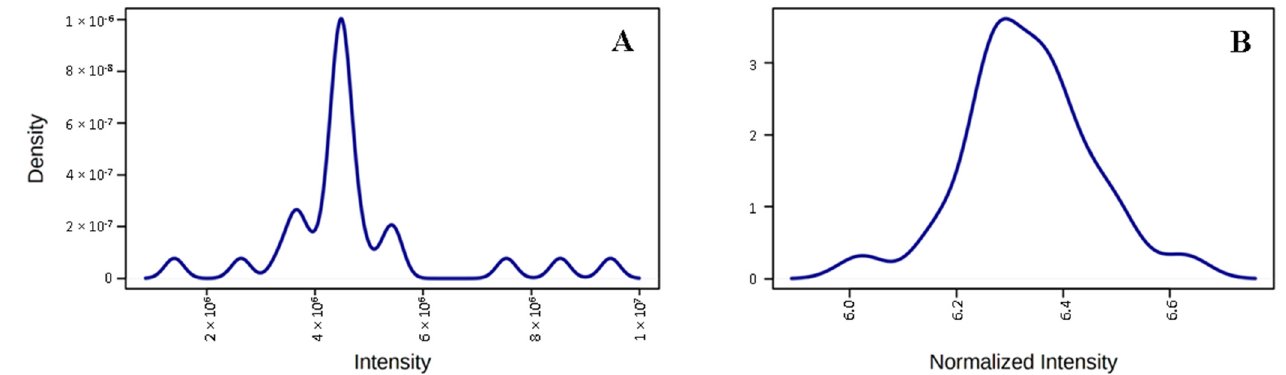
Figure 8. The distribution of the density of the plasma samples of patients with tick-borne diseases (total n = 21) and of healthy donors (n = 8) before ( A ) and after log-transformation, auto-scaling, and normalization by the sum ( B